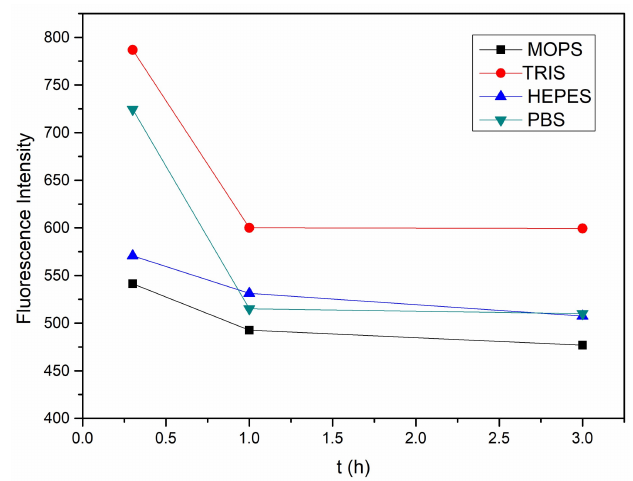
Figure 5. Buffer effect (HEPES, TRIS, MOPS and PBS) on fluorescence intensity of RhB-EDA in the presence of 10 − 4 M Ag + ions depending on time (measurements were taken at time 0, after 60 min and 3 h). λ ex / λ em was selected at 500/538 nm. Slit ex/em 6.0/6.0 nm.